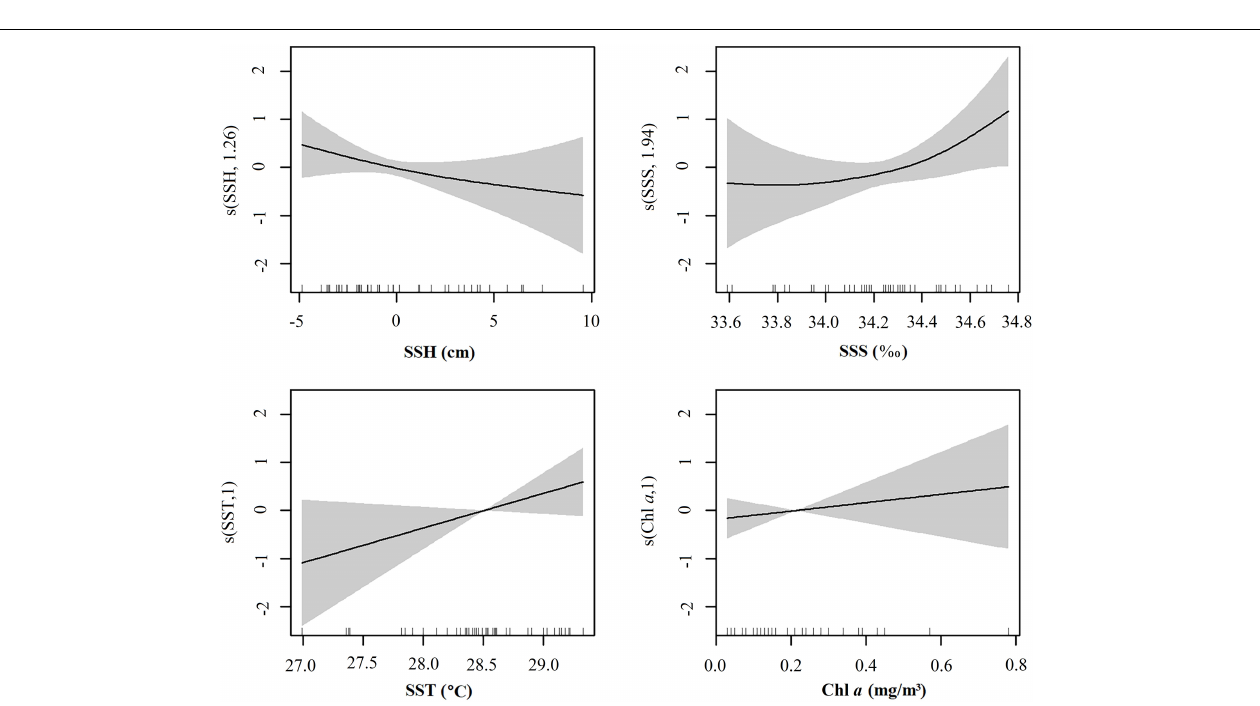
FIGURE 3 | Distributions of fish eggs and larvae, and total numbers of ichthyoplankton caught by stations above Ninety East Ridge.